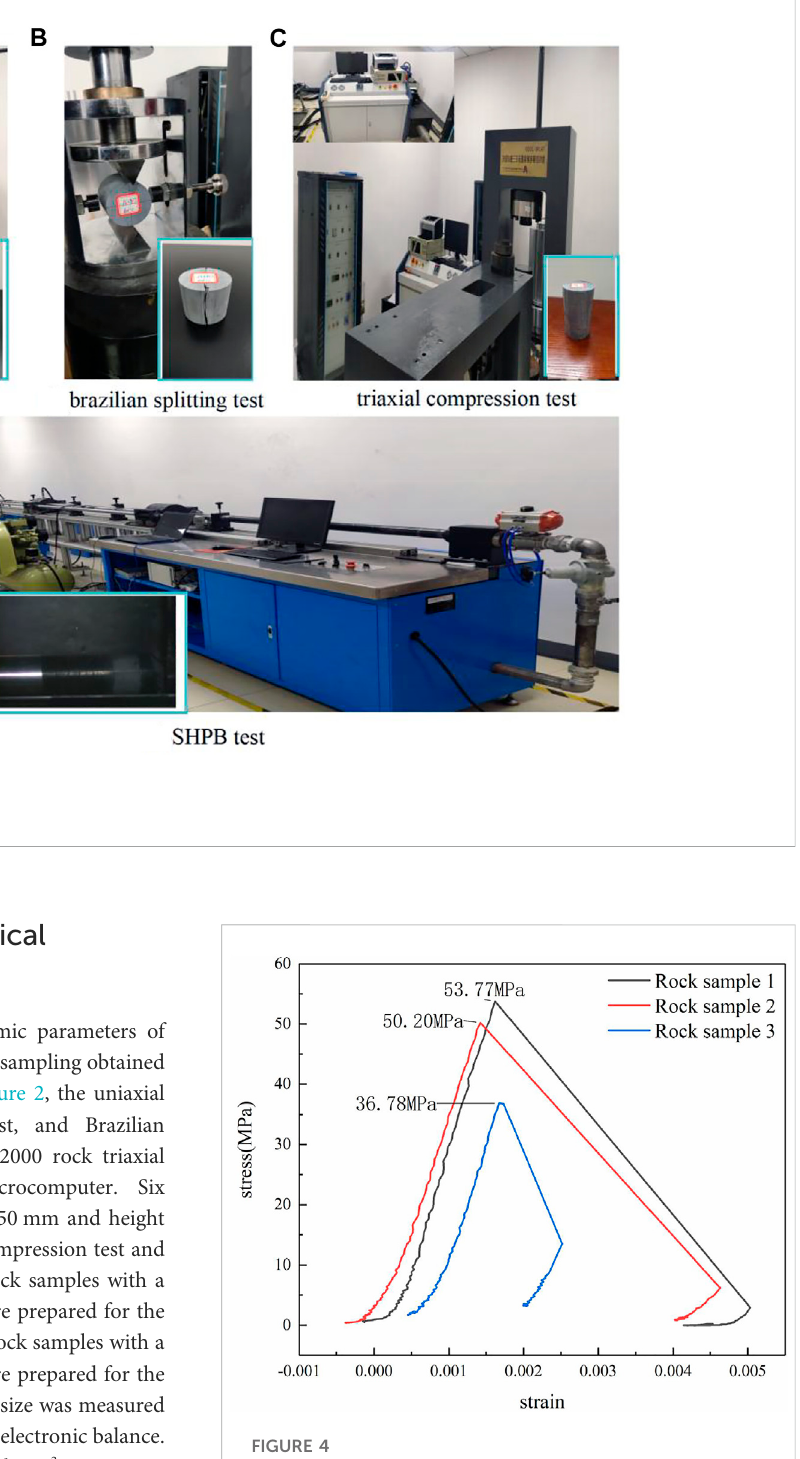
FIGURE 4 Stress – strain curve of uniaxial